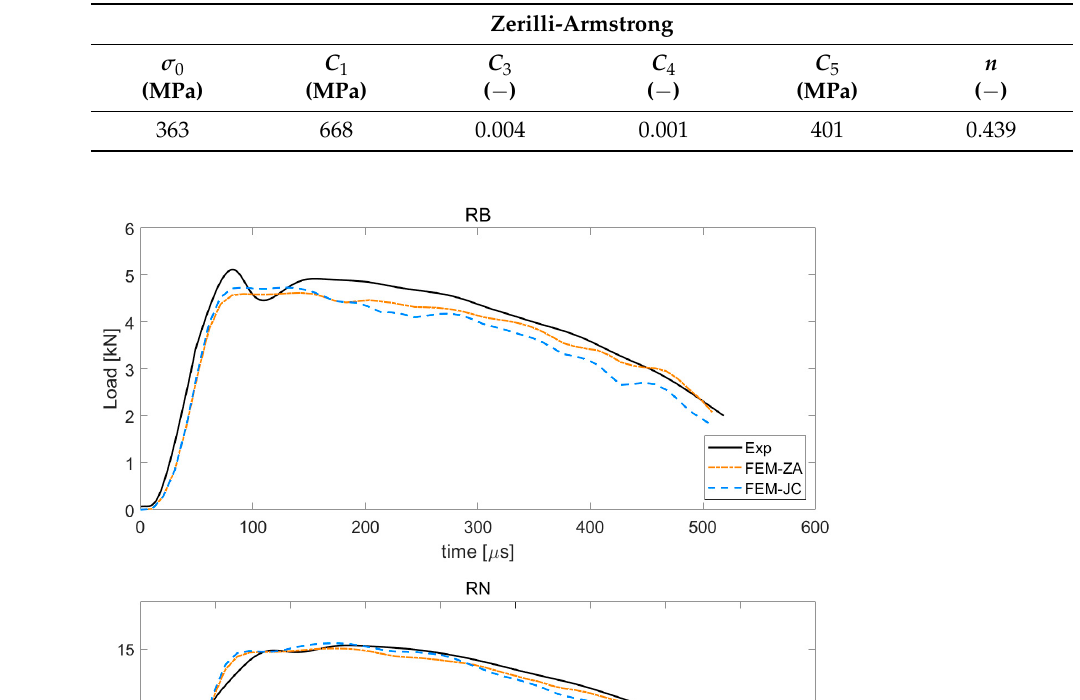
Figure 9. Comparison between the deformed shape observed in the real experiments and the shapes predicted by FE analyses. Color contours represent the equivalent plastic strain distribution com- puted with the ZA model.